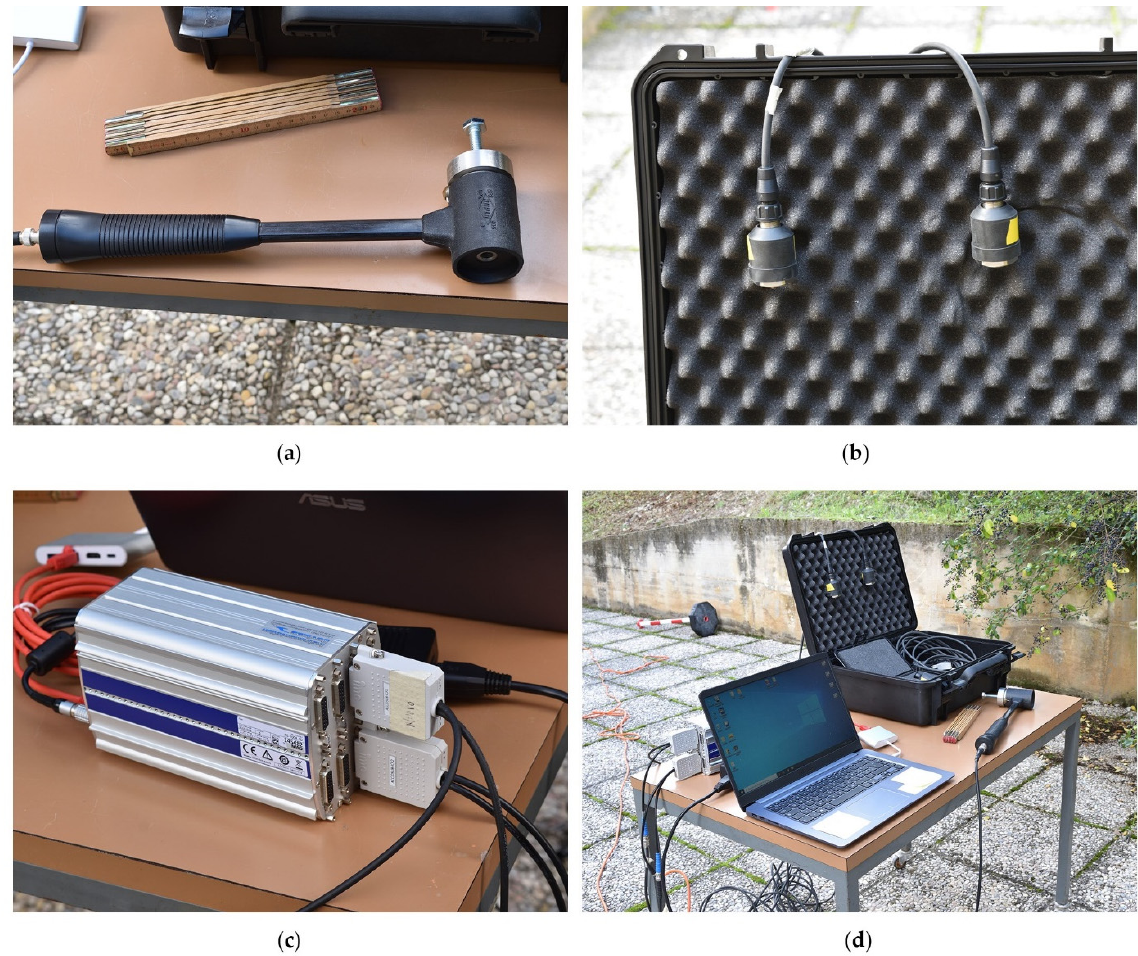
Figure 2. ( a ) Instrumented hammer PCB 086D20 with head bolt. ( b ) High-sensitivity piezoelectric uniaxial accelerometers PCB 393B12 used in the tests. ( c ) Data acquisition system. ( d ) General view of the experimental setup.